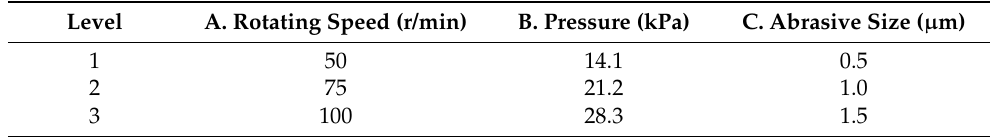
Table 2. The control factors and their levels in polishing